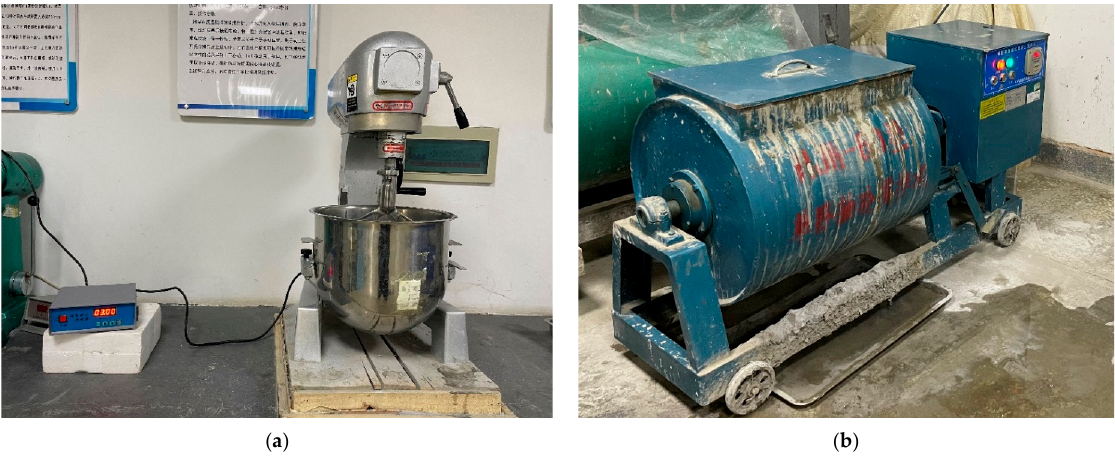
Figure 2. Specimen preparations. ( a ) SSPP-ECC preparation; ( b ) Concrete preparation.